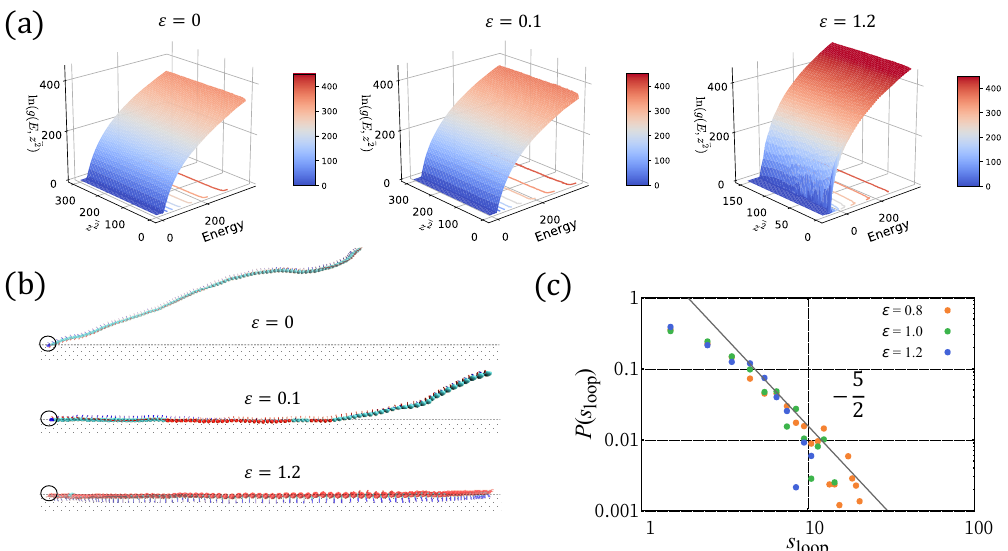
Figure A2. ( a ) DOS g ( E , ¯ z 2 ) of WLCT filament interacting with short range attractive potential. ( b ) Representative conformation of WLCT at weak( (cid:101) = 0.1) and strong ( (cid:101) = 1.2) adsorption regime. ( c ) Loop length distribution P ( s ) . The line represent the scale of adsorption loop length distribution P ( s ) ∝ s − 5/2